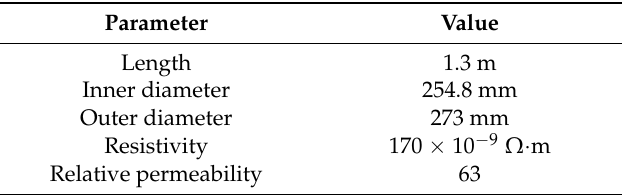
Table 1. Pipe parameters.